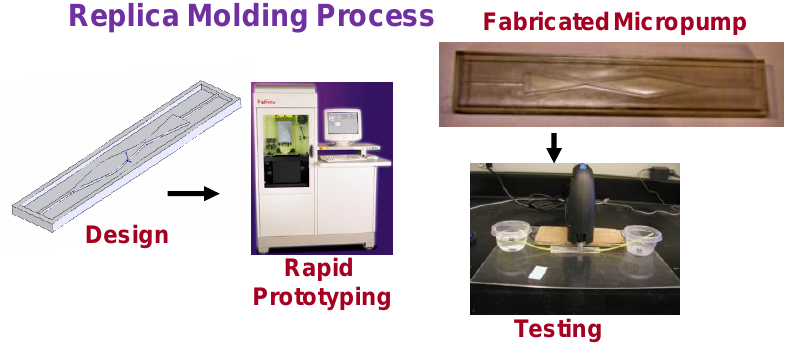
Figure 2. Prototyping the device for fluidic transport.